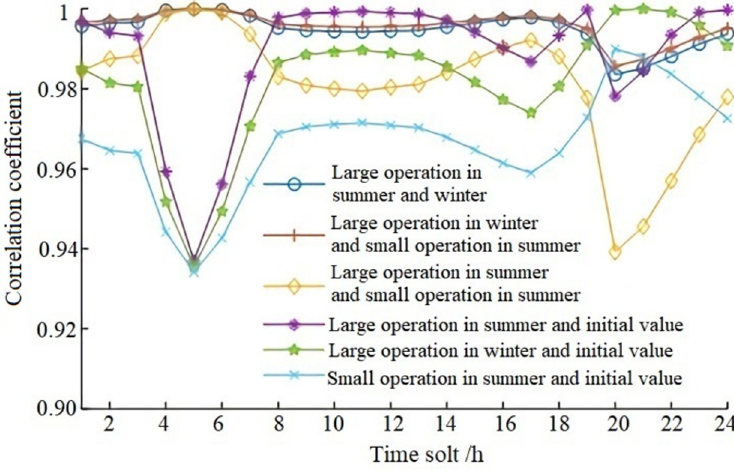
Fig 3. The correlation coefficient of voltage deviation under multiple combined operation modes.